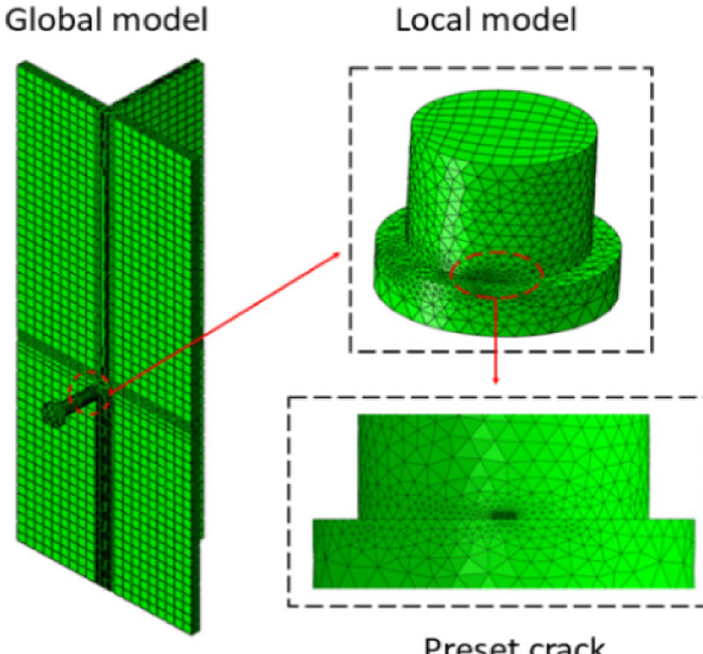
Fig. 14 Prefabricated stud model